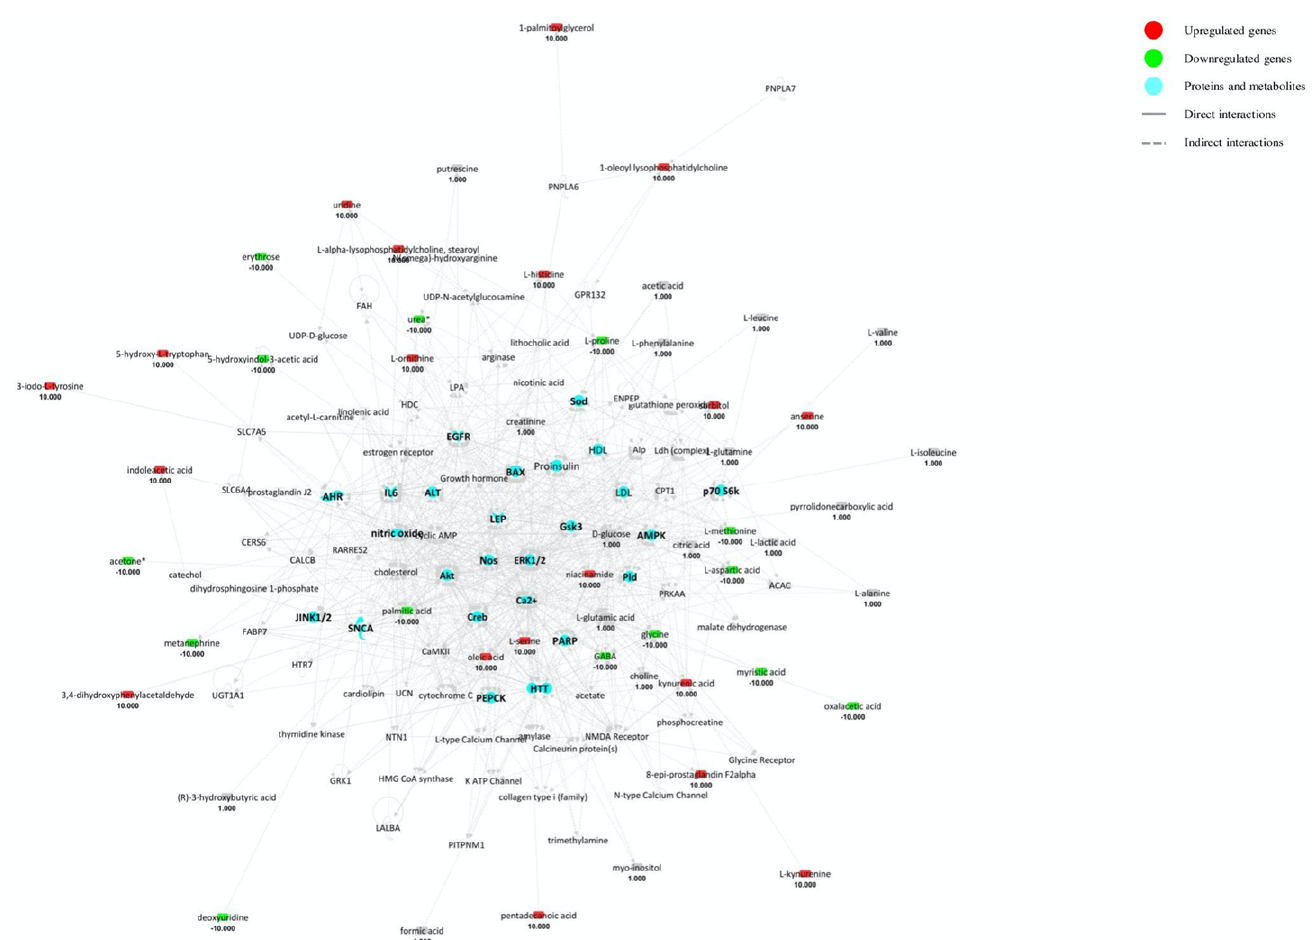
Figure 3. Merged networks based on inter-metabolite connections from the cerebrospinal fluid (CSF) matrix. Red and green shapes indicate genes significantly increased and decreased in expression in MS patients, whereas the number below represents the fold change log. The relationship between genes may lead to direct (solid lines) or indirect interaction (dashed lines). Light blue shapes indicate proteins and metabolites from the CSF matrix.